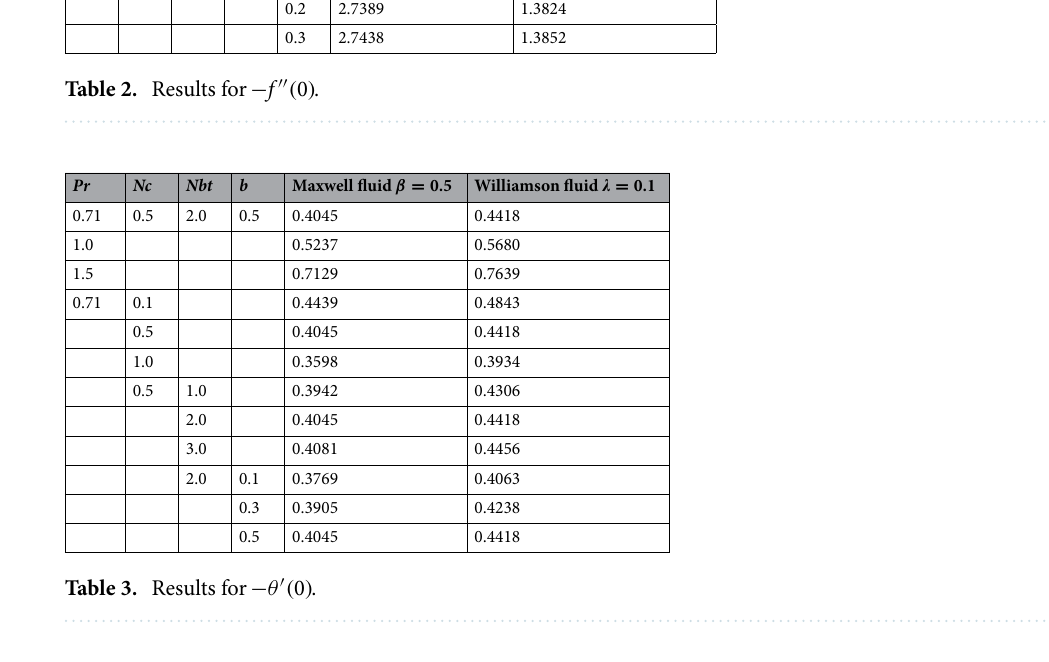
Table 2. Results for